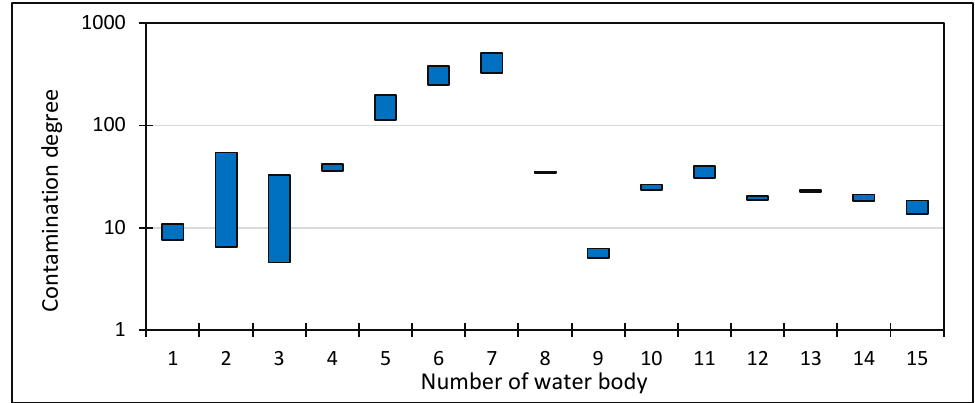
Figure 2. Degree of contamination of bottom sediments of water bodies used for recreational purposes in the Silesian Upland and its periphery (numbering of water bodies — see Figure 1).